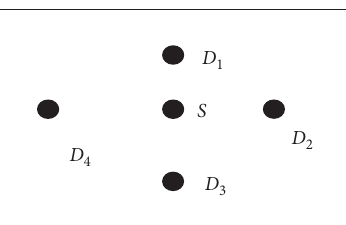
Figure 3: Topology